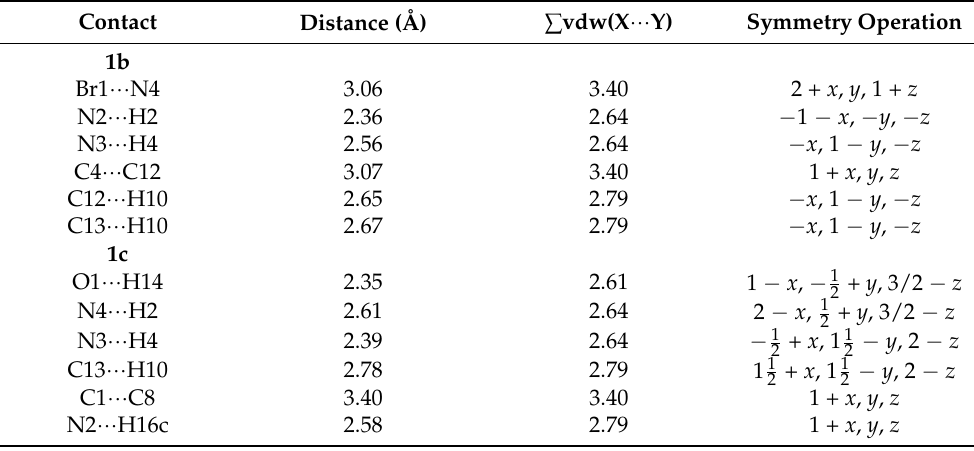
Table 3. List of contact distance between the corresponding red spots as identified on the d norm - surfaces for 1b and 1c